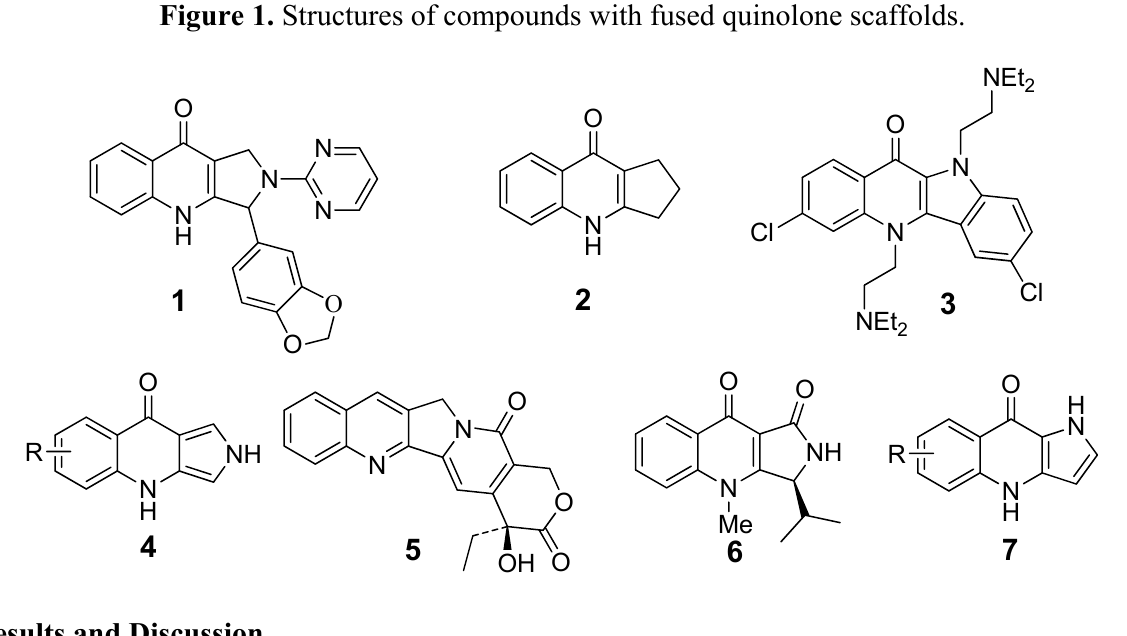
Figure 1. Structures of compounds with fused quinolone